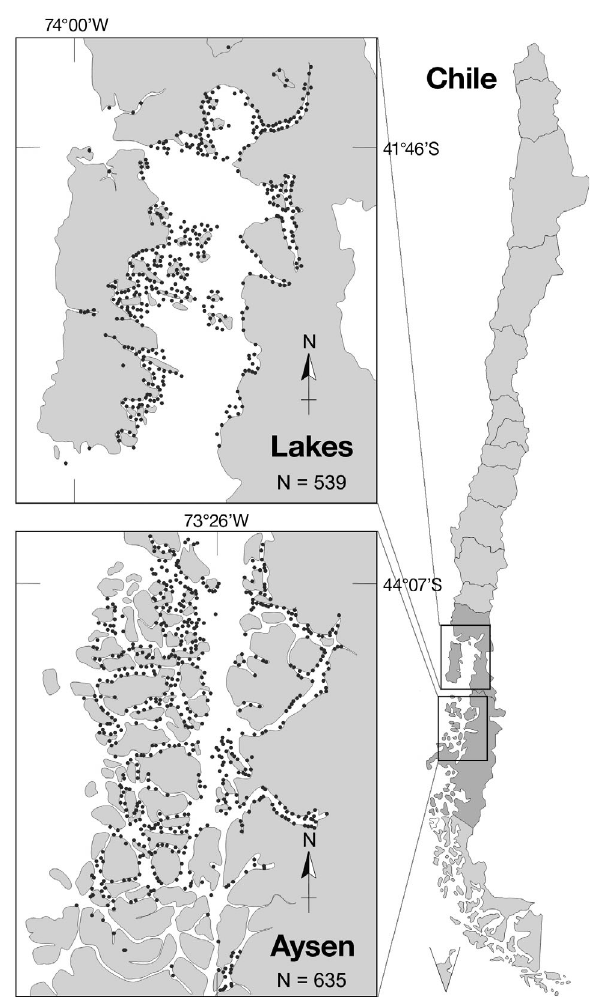
Fig. 2. Salmonid farm locations (black dots) in the Lakes and Aysen regions of